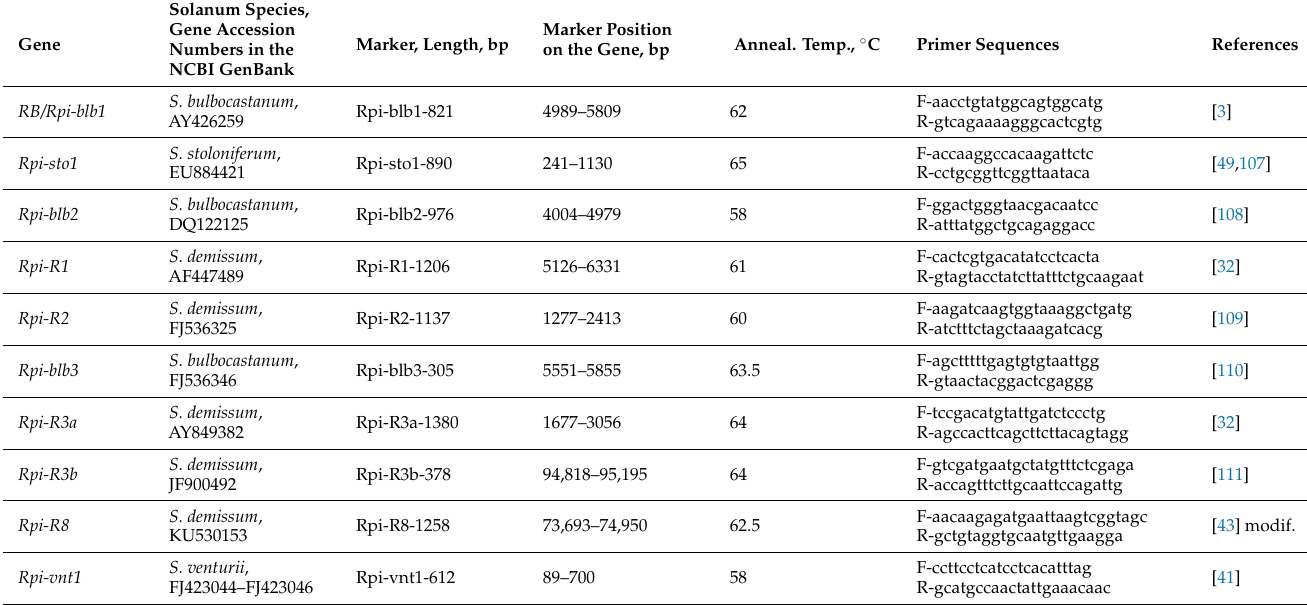
Table 4. SCAR markers of the Rpi genes used in this